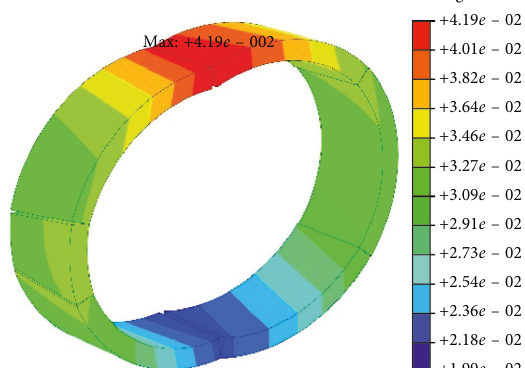
Figure 11: Deformation nephogram of the critical section A-A the tunnel segment at the shield arrival